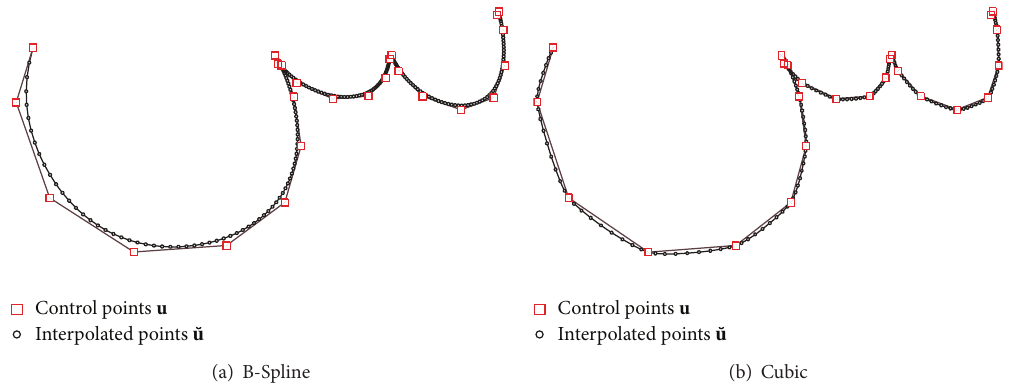
Figure 9: Comparison of B-Spline and Cubic interpolation where 𝑛( u ) = 25 and 𝑛( ̆ u ) =